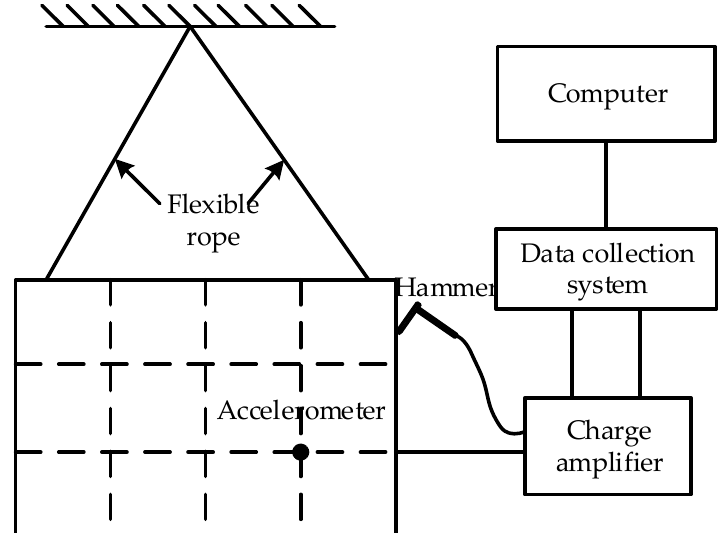
Figure 4. Schematic diagram of the modal test.